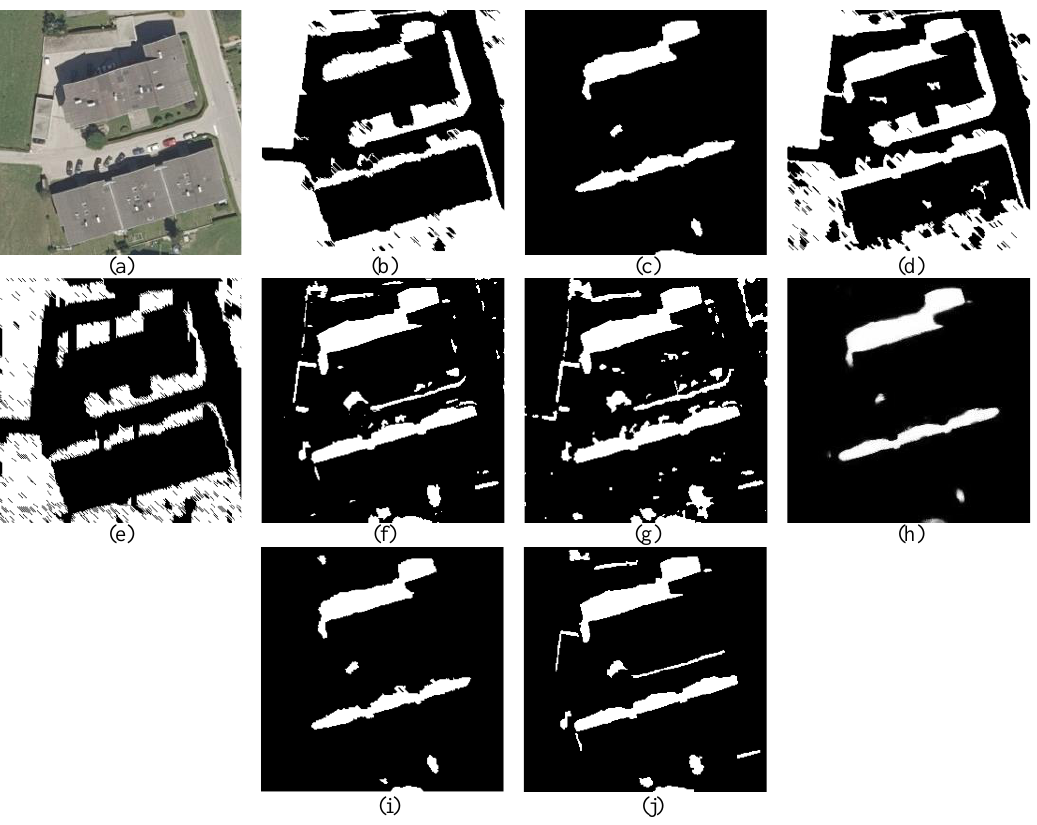
Figure 9. ( a ) Original image; ( b ) SRHI; ( c ) NB; ( d ) HTD; ( e ) C1C2C3; ( f ) U-Net method; ( g ) Segnet method; ( h ) BDRAR method; ( i ) DLA-PSO method; ( j ) ground truth. Table 6. Tyrol shadow-test-evaluation index.